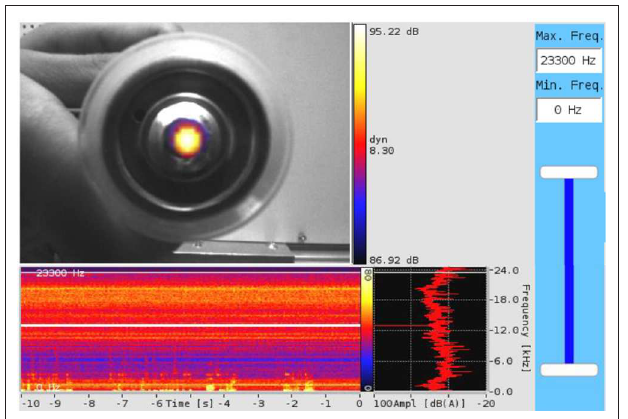
FIGURE 12 | The interface of SoundCam and full-field image of acoustic field for isi-sys transducer (frequency 13100Hz).